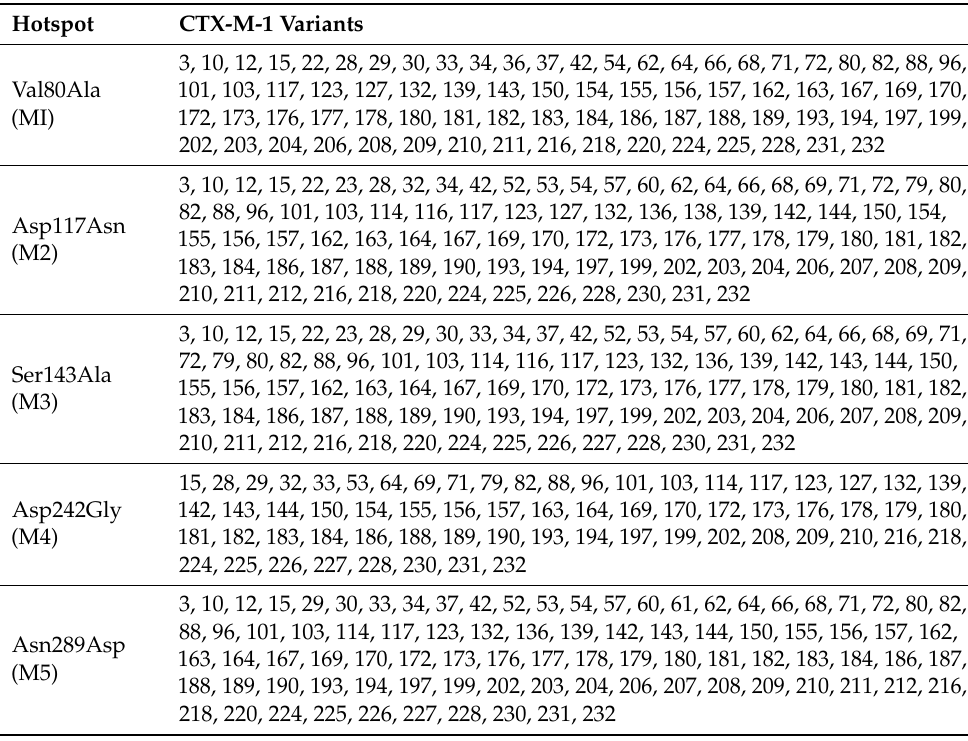
Table 1. Distribution of CTX-M-1-like enzymes by major hotspot mutation sites. M1 to M5 represent the five hotspots in CTX-M-1 cluster; For each hotspot, the substitution of the respective amino acid is represented; The numbers for each hotspot represent the indexes of all the enzymes from the CTX-M-1 cluster that present the corresponding